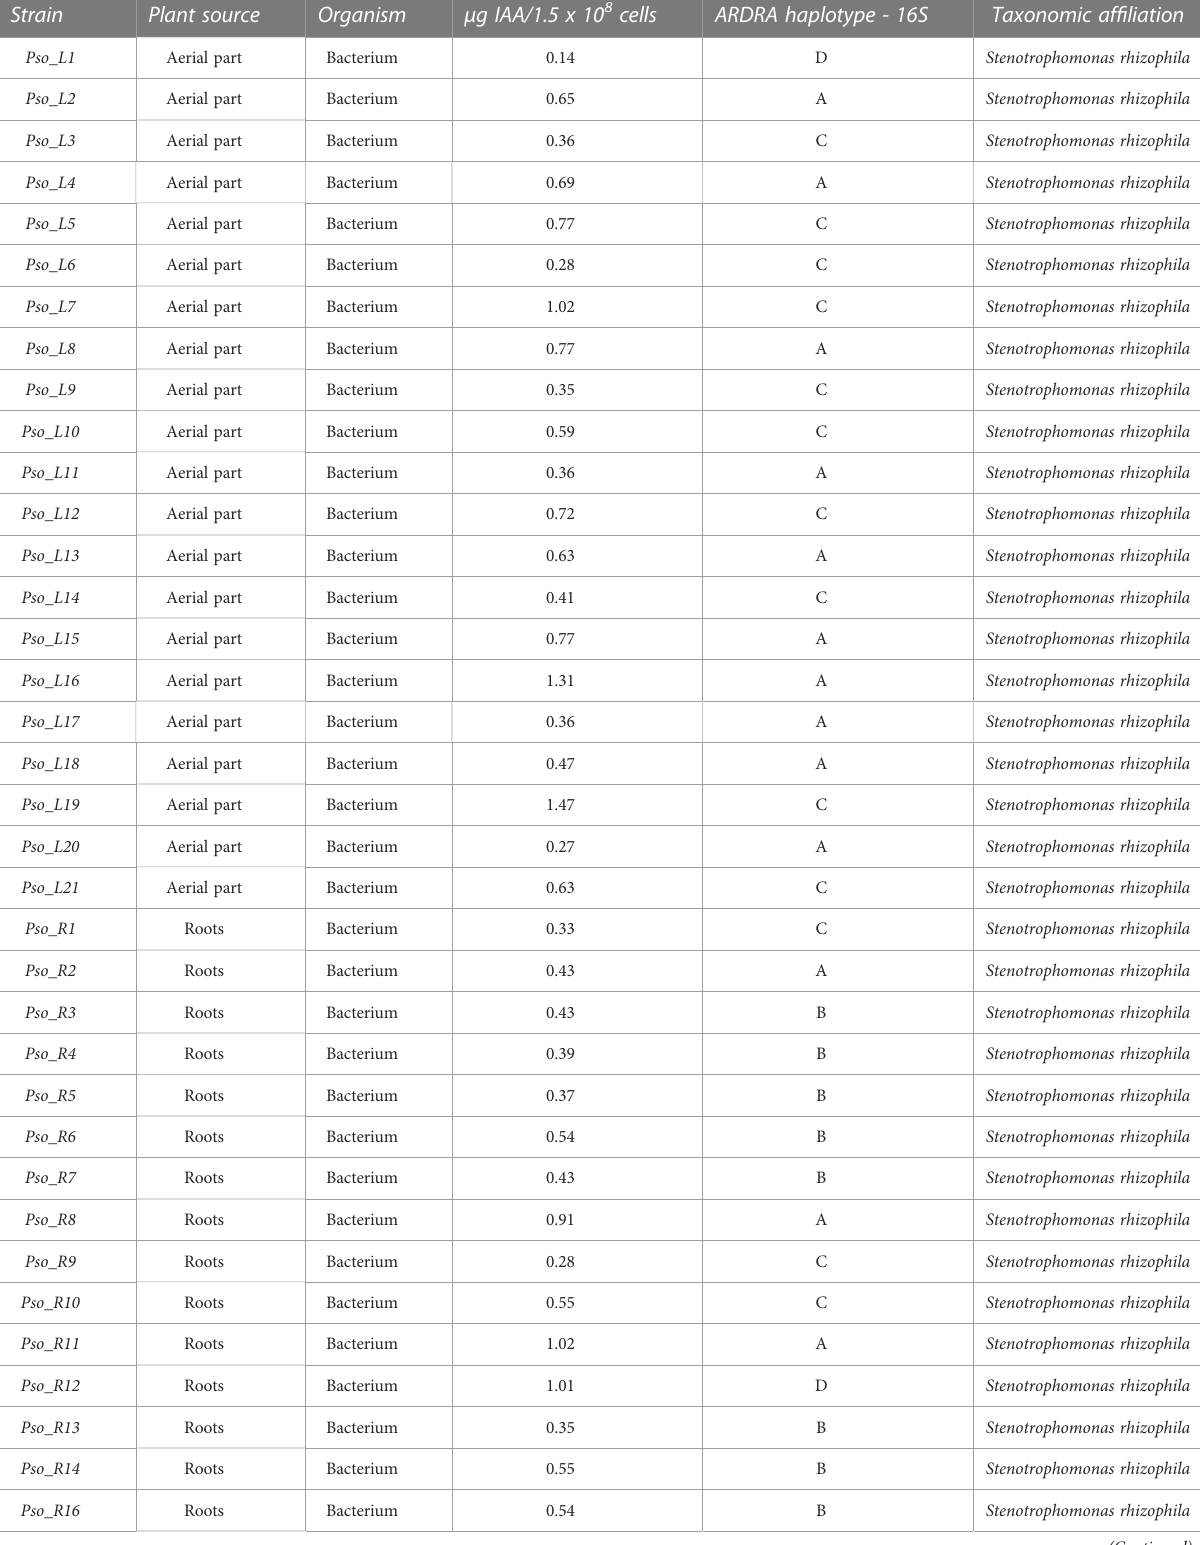
TABLE 4 Haplotype attribution, taxonomy, plant source, and IAA production of the endophytic bacterial strains isolated from the plants.